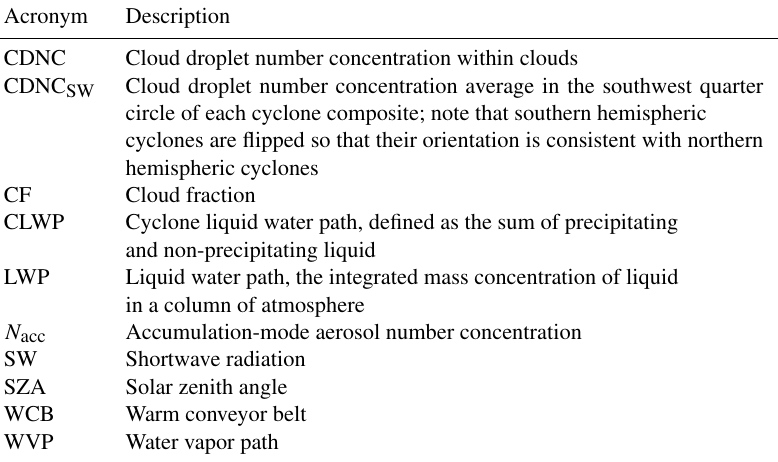
Table 1. Acronyms used in this